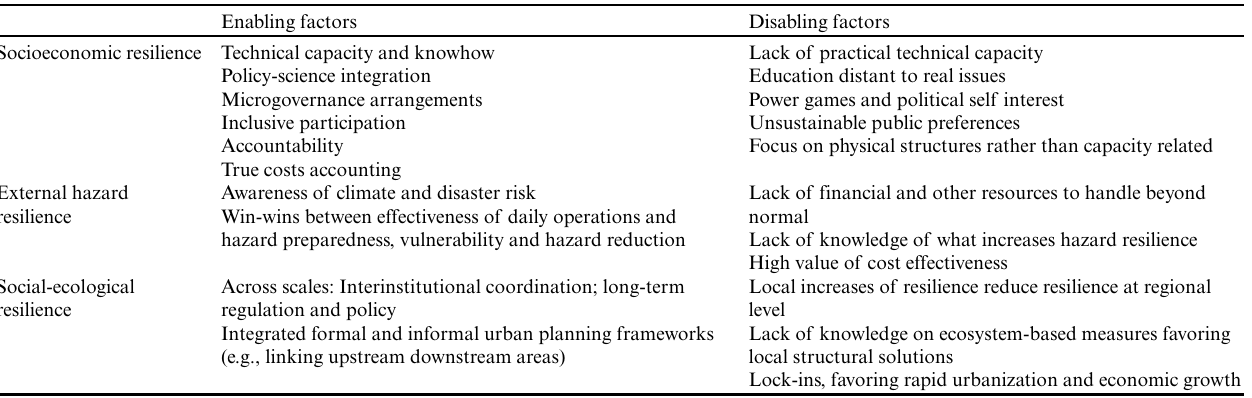
Table 1 . A summary of the enabling and disabling factors that influence the different resilience levels identified from the empirical